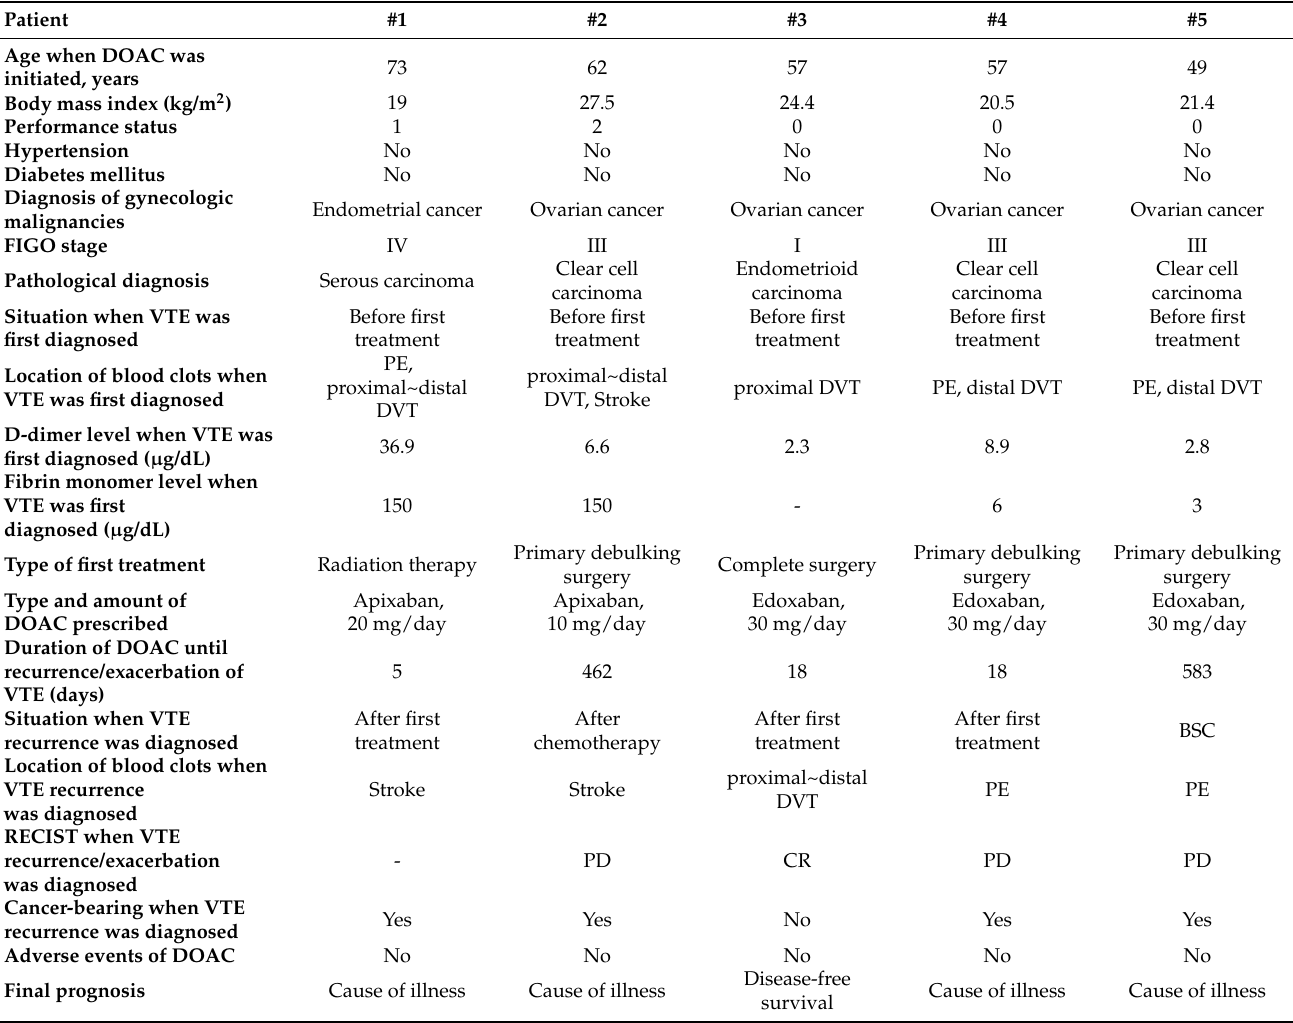
Table 3. Characteristics of participants with VTE